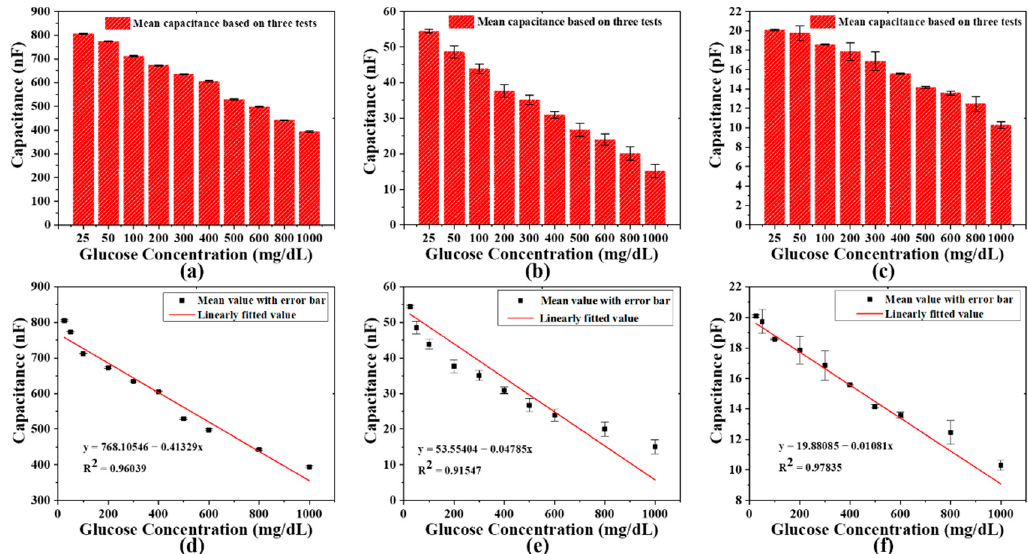
Figure 5. The average of three sensing responses of the capacitor-based biosensor to different concentrations of glucose solution at: ( a ) DC signal frequency; ( b ) 1 kHz signal frequency; ( c ) 1 MHz signal frequency. Regression analysis is performed for different glucose concentrations (n = 10) at: ( d ) DC signal; ( e ) 1 kHz signal; ( f ) 1 MHz signal.